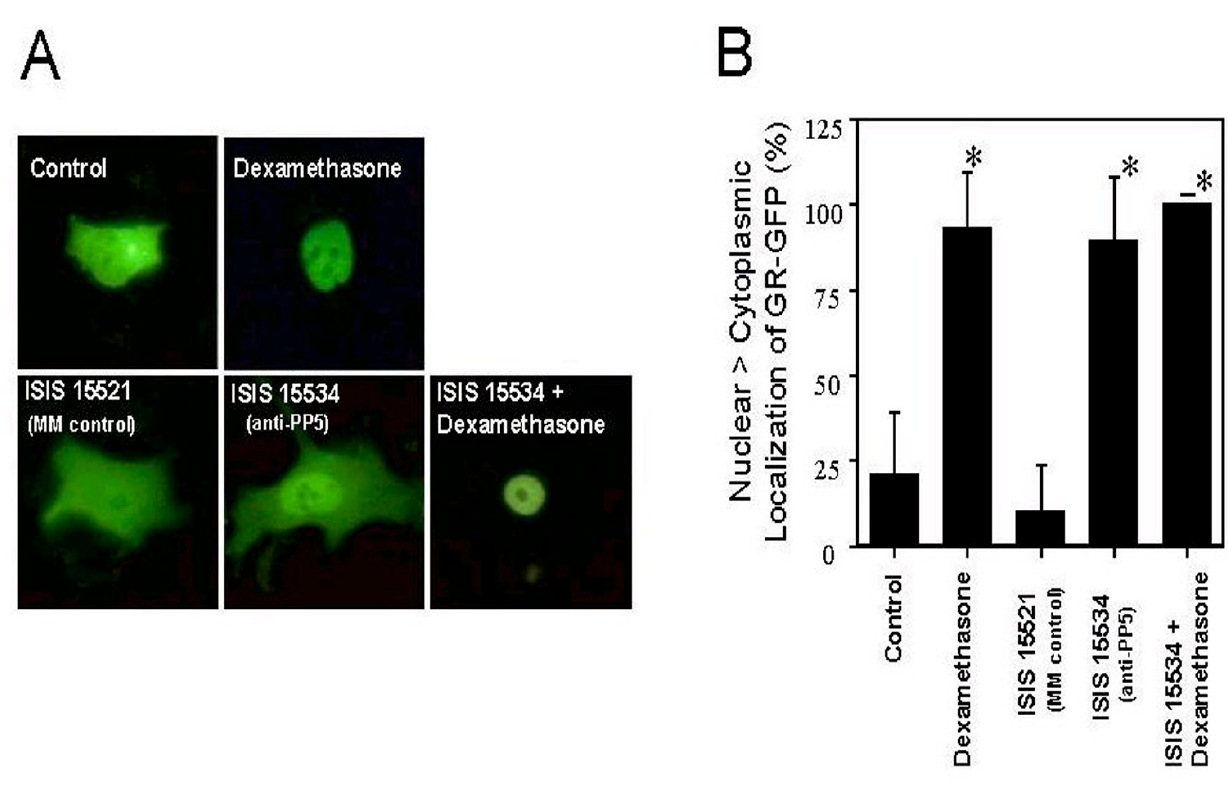
Figure 2 Effects of ISIS 15534 and dexamethasone on the subcellular distribution of GR-GFP. A. Representative subcel- lular distribution of GR-GFP. A549 cells were grown and treated with ISIS 15521 (a mismatched control antisense oligonu- cleotide for ISIS 1535), ISIS 15534 (antisense targeting PP5), dexamethasone (500 nM), ISIS 15534 and 500 nM dexamethasone, or vehicle alone (control) as described in Material and Methods. Eighteen hours later, GR-GFP expressing plasmids were microinjected into the nuclei of cells, incubated for 6 hours in serum-containing medium, and then serum-starved for an addi- tional 18 hours. Between 150 and 200 cells were injected for each condition. The cells were either left untreated (control, ISIS 15521, ISIS 15534) or incubated with 500 nM dexamethasone (dexamethasone, ISIS + dexamethasone) for 30 minutes, prior to fixing and observation by fluorescence microscopy. Representative cells from 4 independent experiments are shown. B. Per- centage of cells displaying nuclear GR-GFP. Cells from 4 independent experiments were scored for their intracellular distribution of GR-GFP and the mean percentage of cells having greater fluorescence in their nuclei than cytoplasm are shown ( ± SD). * p ≤ 0.0001 by ANOVA vs untreated or mismatch-treated